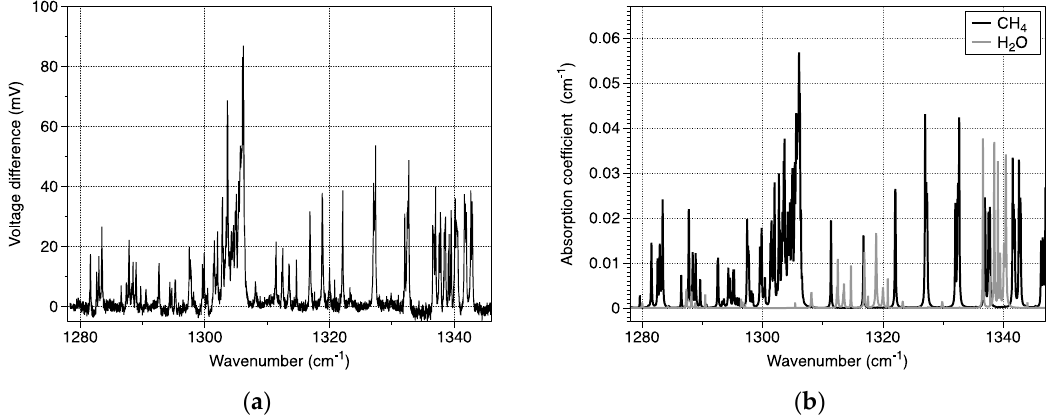
Figure 11. ( a ) Experimental spectra and ( b ) absorption coefficient calculated from HITRAN data assuming 0.3% of methane and 3% of water vapor in ambient air at atmospheric pressure.